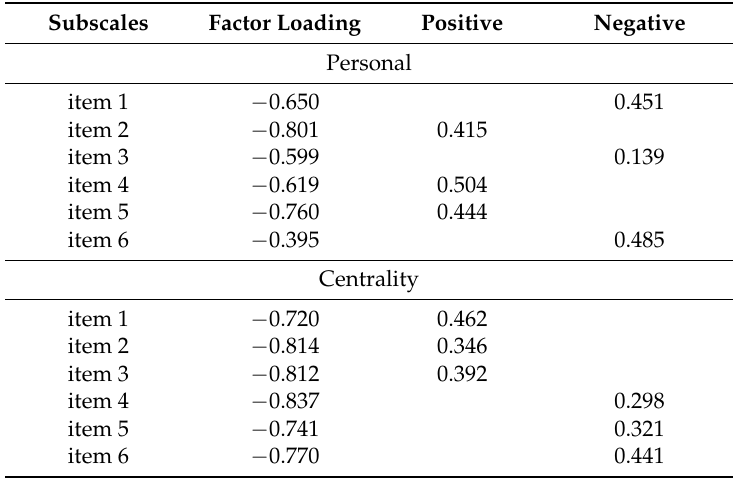
Table 6. Factor Loadings for the CFA Model